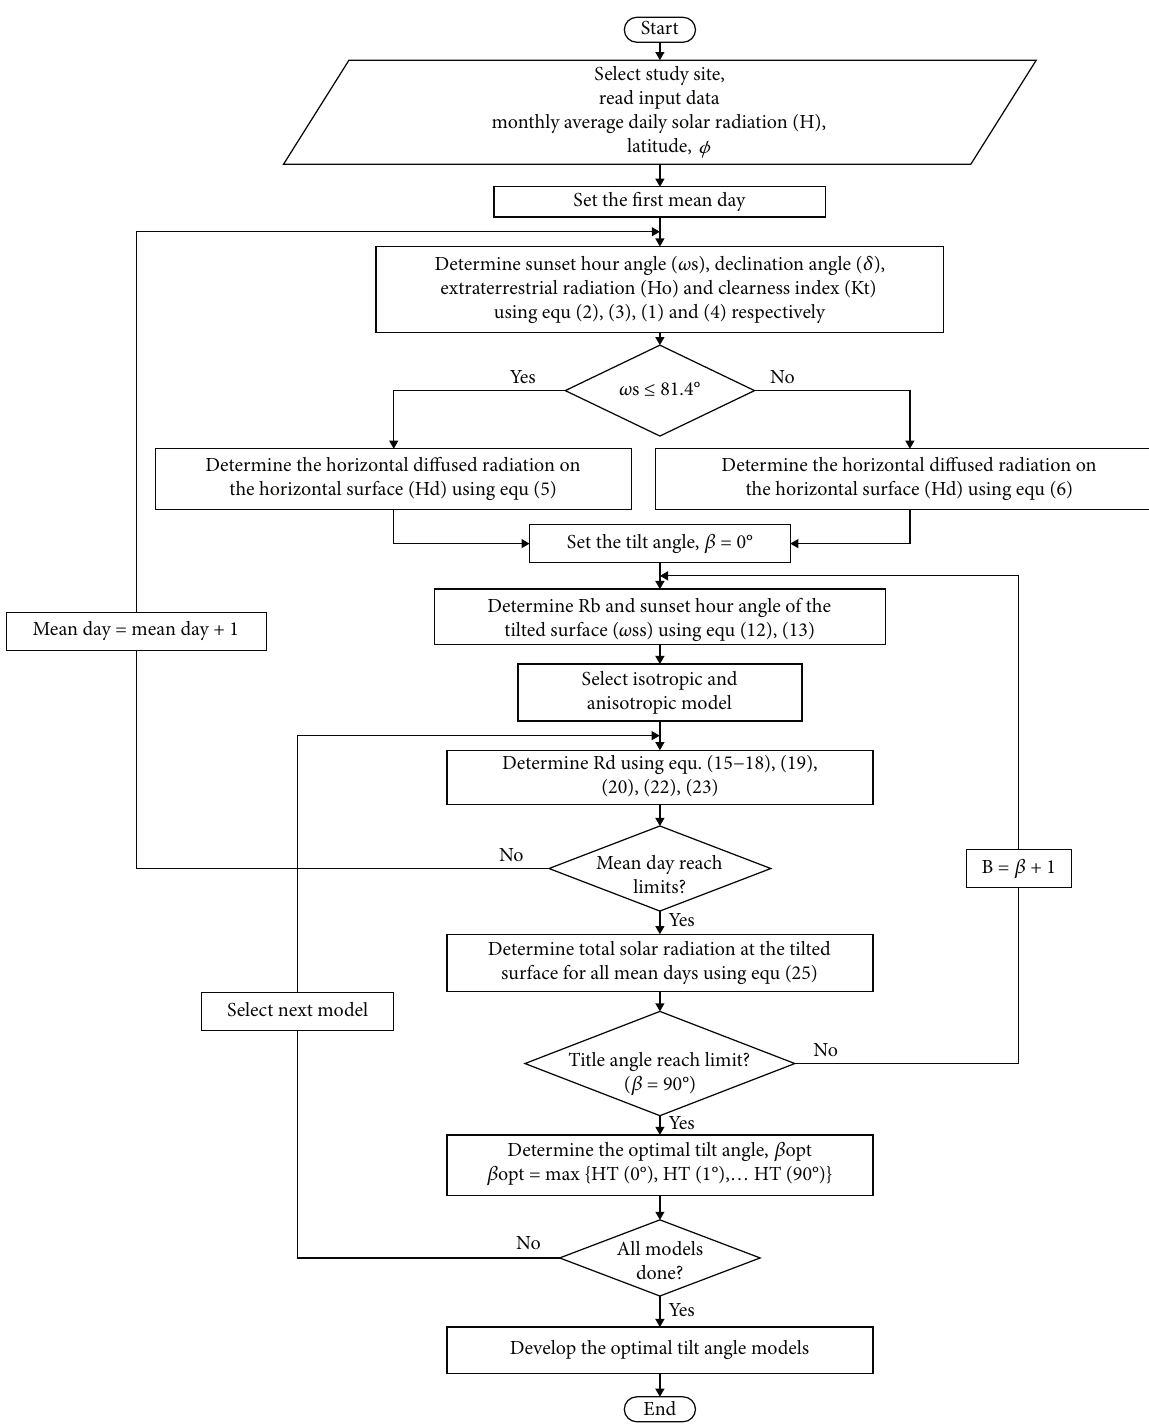
Figure 2: Flow chart for the procedure in determining the optimal tilt angle